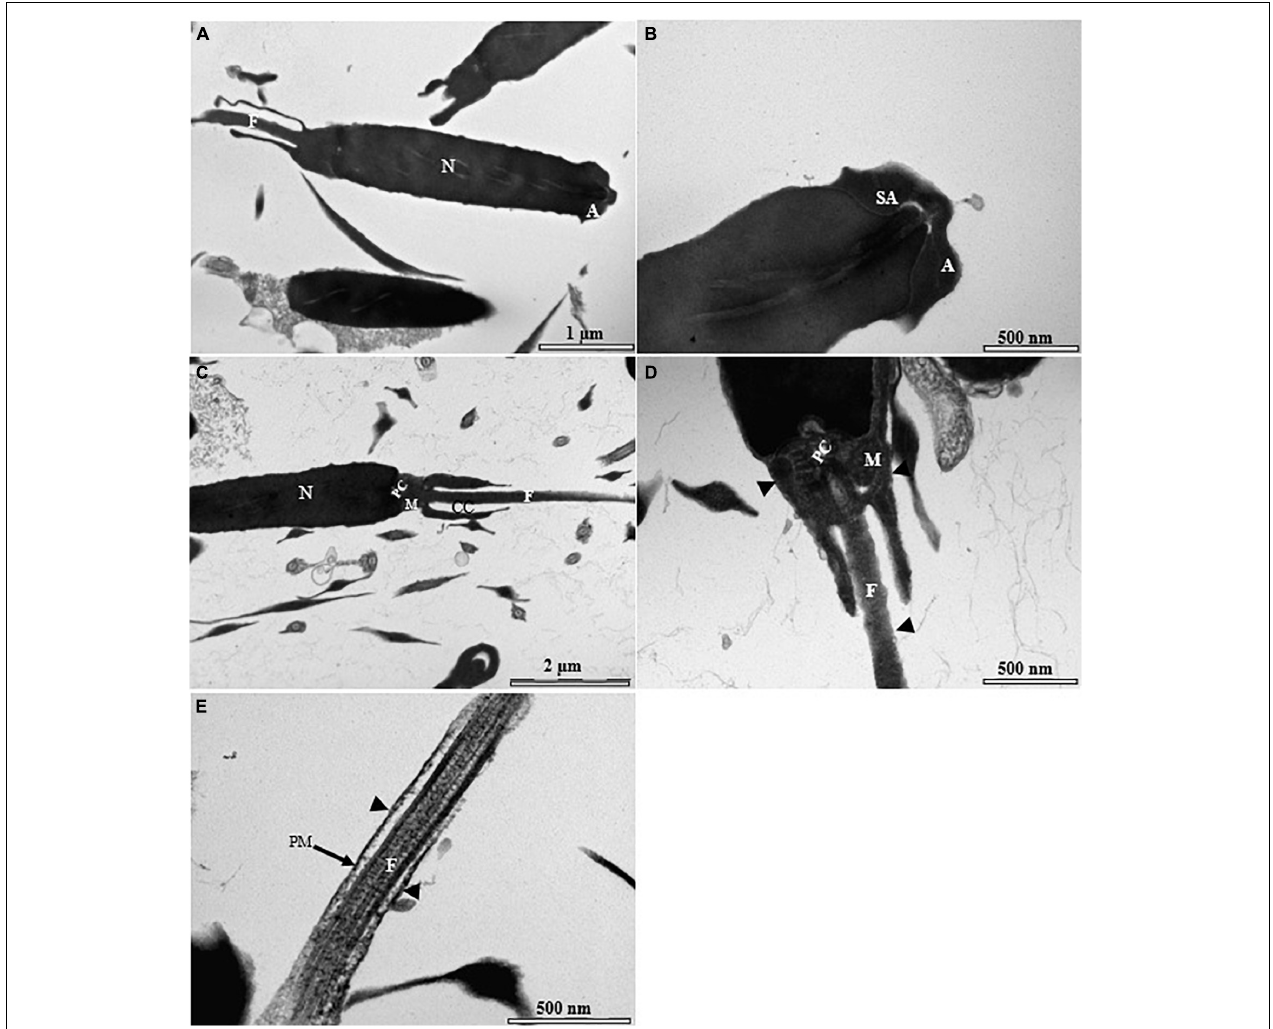
FIGURE 9 | Transmission electron micrographs of cryopreserved spermatozoon with supplementation of antifreeze protein type I (AFPI) in sterlet. (A) Longitudinal sagittal section of cryopreserved spermatozoon showing different parts of the cell; (B) higher magnification of cryopreserved spermatozoon head region showing the unchanged acrosom, sub-acrosome area, and nucleus; (C) longitudinal sagittal section of midpiece exhibiting damage to the midpiece spermatozoon; (D) higher magnification of spermatozoon midpiece region showing visible damage in the mitochondria, midpiece envelope, and plasma membrane of the flagellum (black arrowheads); (E) higher magnification of spermatozoon flagellum showing rupture of the plasma membrane of the flagellum (black arrowheads). A, acrosome; Ax, axenome; CC, cytoplasmic channel; F, flagellum; M, mitochondrion; N, nucleus; PM, plasma